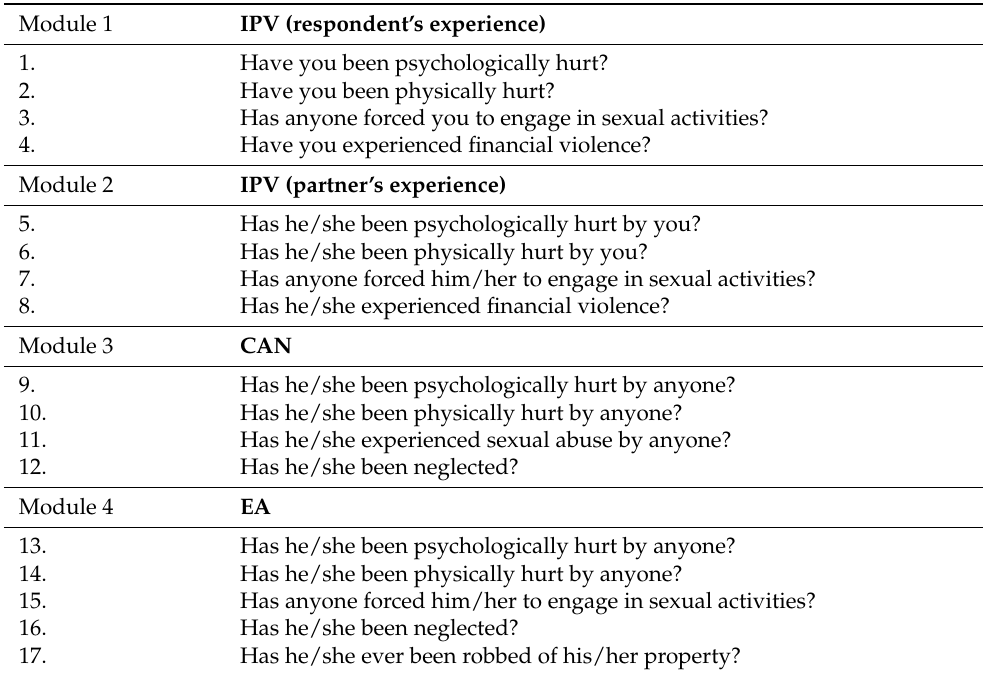
Table A1. Items of the Japanese Version of the Family Polyvictimization Scale